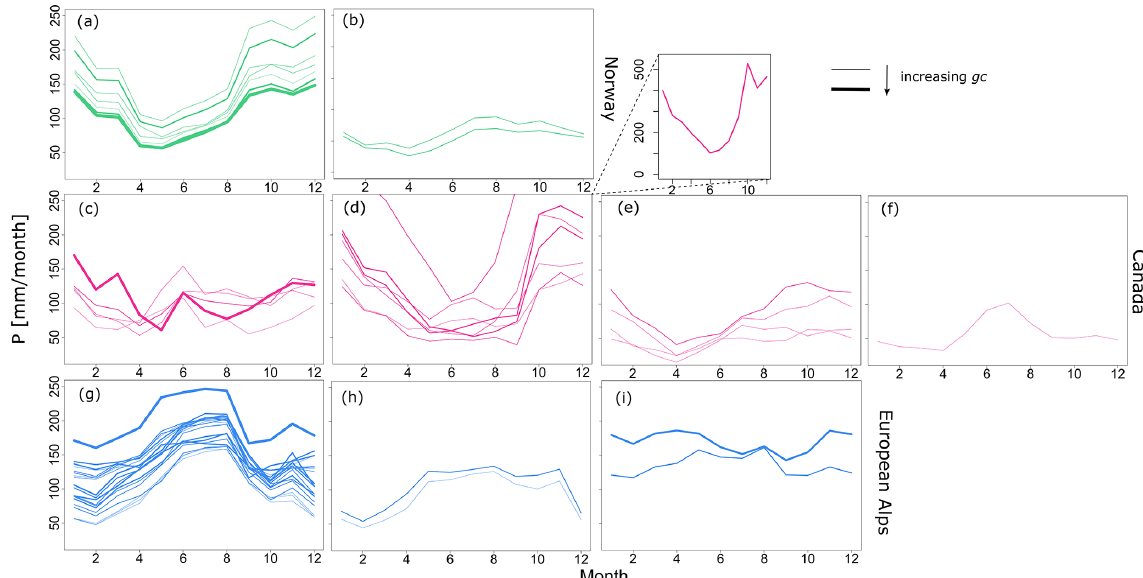
Figure 2. Precipitation seasonality of the glacierized catchments in southwestern Norway (a, b) , western Canada (c–f) and the European Alps (g–i) . The graph connected to (d) shows a different y -axis scale for one catchment that had large monthly precipitation amounts. The precipitation distribution over the year of the different catchments was grouped into several precipitation regimes per region: two in southwestern Norway, four in western Canada, and three in the European